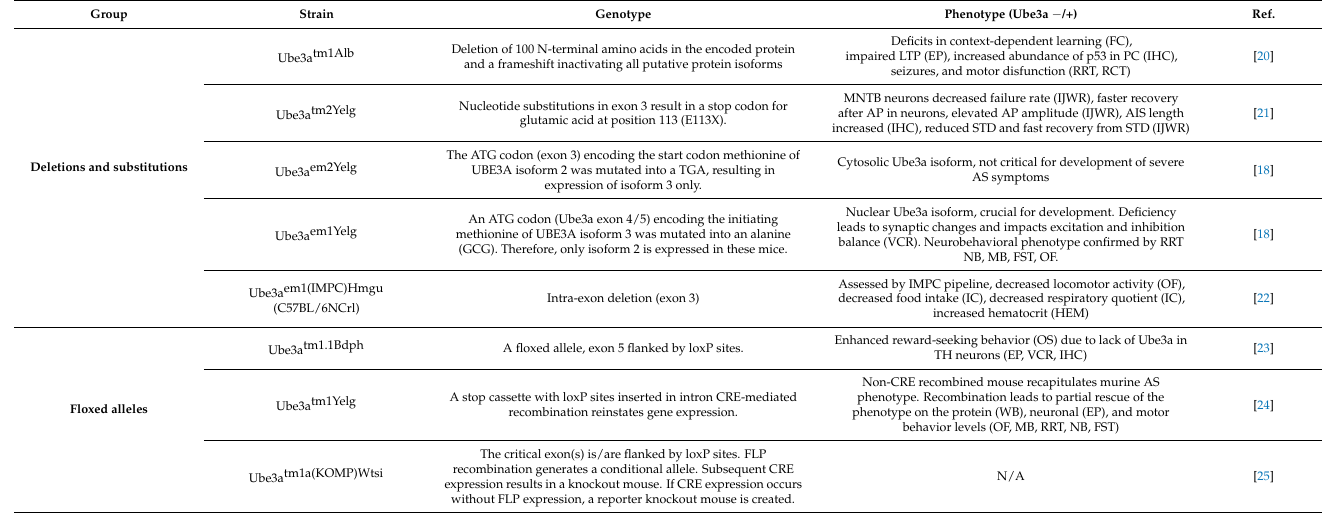
Table 1. Summary of Angelman mouse models (previously generated models are summarized and grouped depending on type of